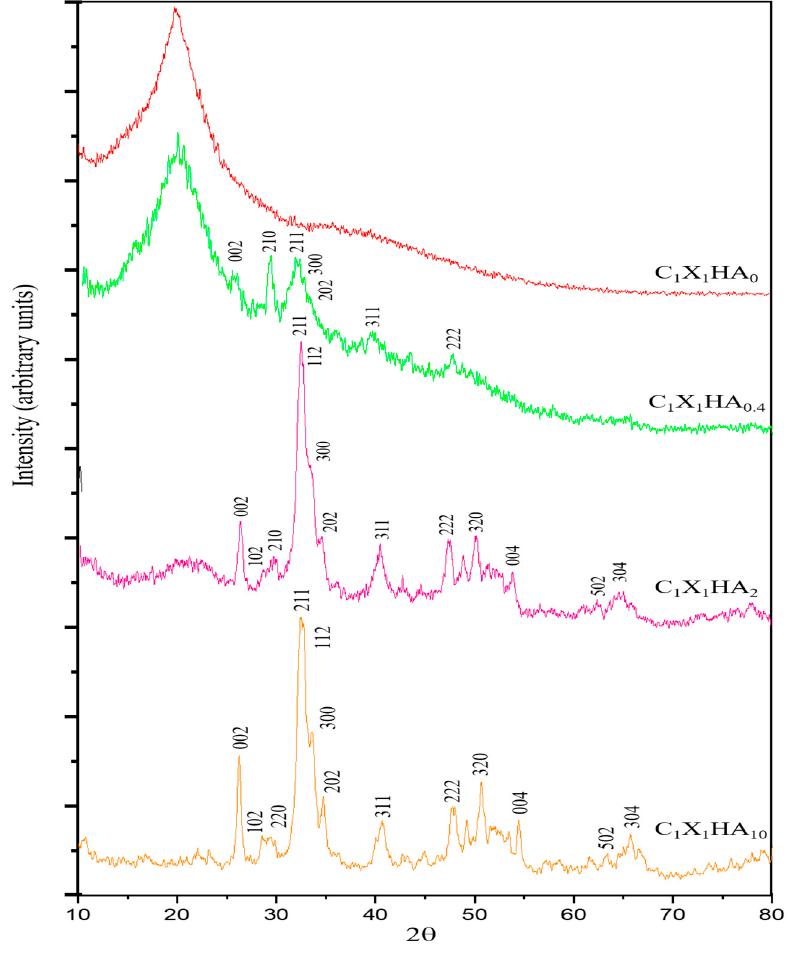
Figure 1. X-ray diffractograms obtained for hydroxyapatite-chitosan-xanthan gum membrane formulations and pristine HA powder.